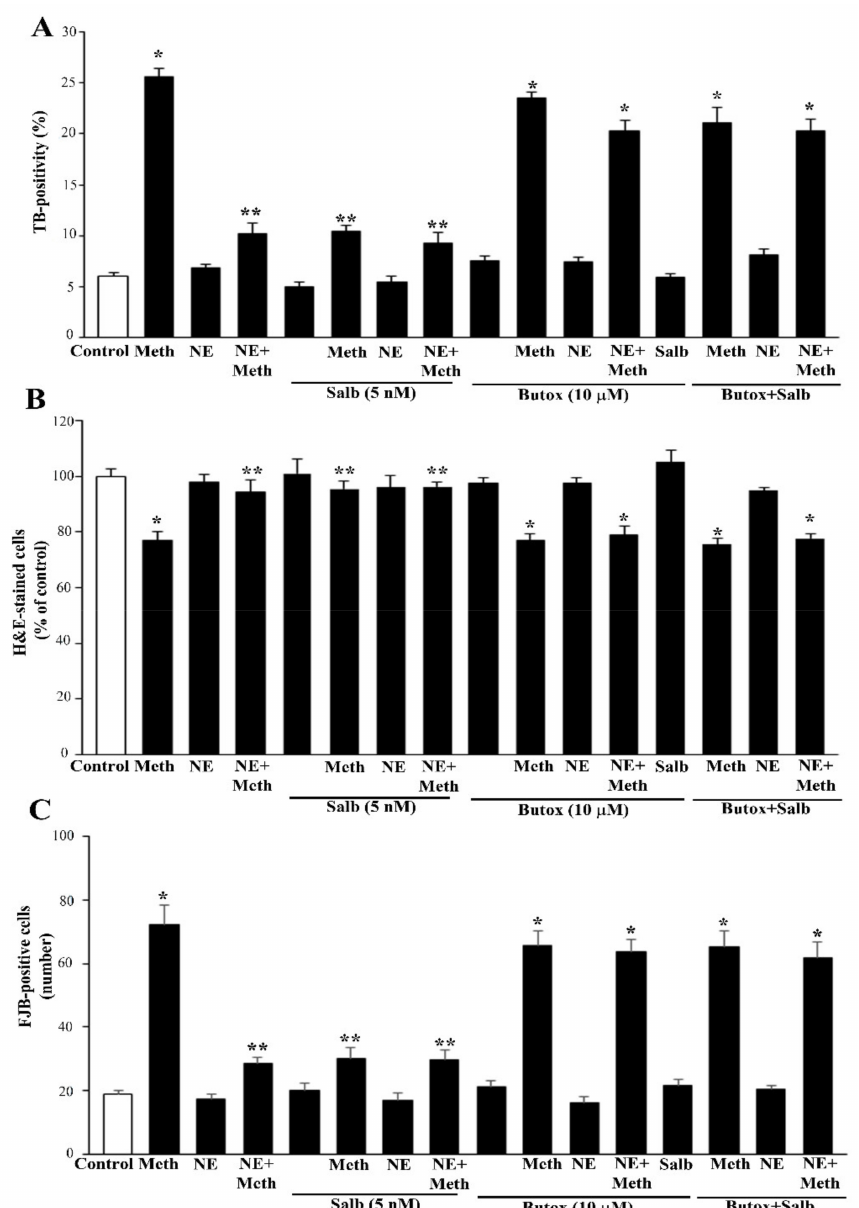
Figure 4. Pre-administration of the β 2-AR agonist (salbutamol) protects against Meth toxicity. This effect is occluded by the β 2-AR antagonist (butoxamine). The selective β 2-AR agonist salbutamol (“Sal”, 5 µ M) fully protects against the toxicity induced by Meth (50 µ M). This protective effect is occluded in the presence of the selective β 2-AR antagonist butoxamine (“Butox”, 10 µ M). Butoxamine also fully prevents NE (5 nM)-induced protection against Meth toxicity, while it does not significantly modify Meth toxicity or spontaneous toxicity ongoing in control cells when administered alone. The effects on cell mortality of the β 2-AR antagonist butoxamine (“Butox”) were assessed on naïve PC12 cells and in PC12 cells exposed to Meth (50 µ M) and/or NE (5 nM). NE was used, either alone or in the group NE + Meth and “NE+Butox + Meth” starting 30 min before Meth administration; butoxamine was administered 15 min before NE in the group “NE+Butox + Meth” or 45 min before Meth in the group “Butox + Meth”. PC12 cells were stained at 72 h after Meth. ( A ) Graph reporting TB staining; ( B ) graph reporting H&E staining; ( C ) graph reporting FJB staining. Data are given as the mean + SEM of nine independent counts for TB; six independent counts for H&E and FJB. Inferential statistics was carried out with ANOVA with Scheff è ’s post hoc analysis. (DF = 15) * p < 0.05 compared with controls. ** p ≤ 0.05 compared with